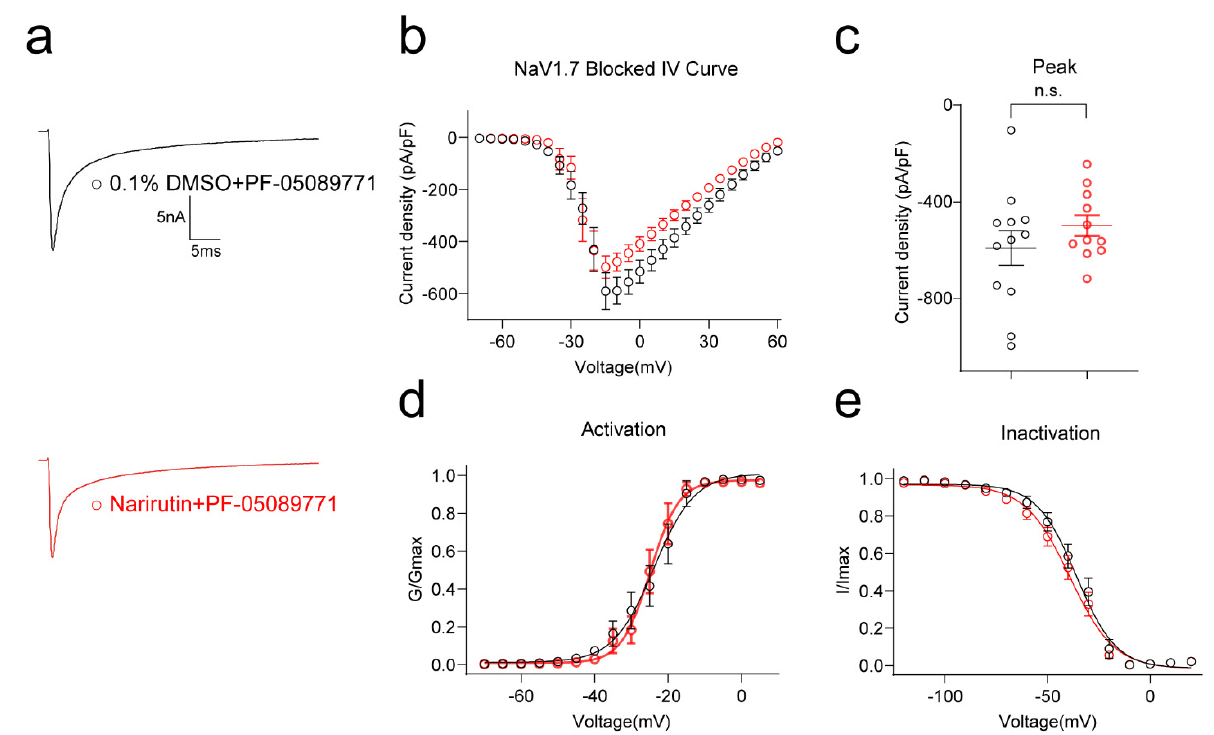
Figure 6. Na v 1.7 inhibitor PF-05089771 blunted the effect of Narirutin on sodium currents. ( a ) Representative traces of Na + currents in DRG sensory neurons after blocking Na v 1.7 with 0.1% DMSO + 100 nM PF-05089771 or 20 µ M Narirutin + 100 nM PF-05089771 treatment. Currents were evoked by 200 ms pulses between − 70 and +60 mV. Summary of ( b ) the normalized (pA/pF) sodium current density versus voltage relationship and ( c ) peak Na + current density (Na v 1.7 blocked) at − 10 mV from DRG neurons treated as indicated. Boltzmann fits for normalized conductance, G/Gmax voltage relationships for voltage-dependent ( d ) activation, and ( e ) inactivation sensory neurons. The half-maximal activation (V 1/2 ) and slope values ( k ) for activation and inactivation are summarized in Table 1. Data are expressed as means ± SEM. ( p > 0.05, Mann–Whitney test, n > 9 cells per condition).